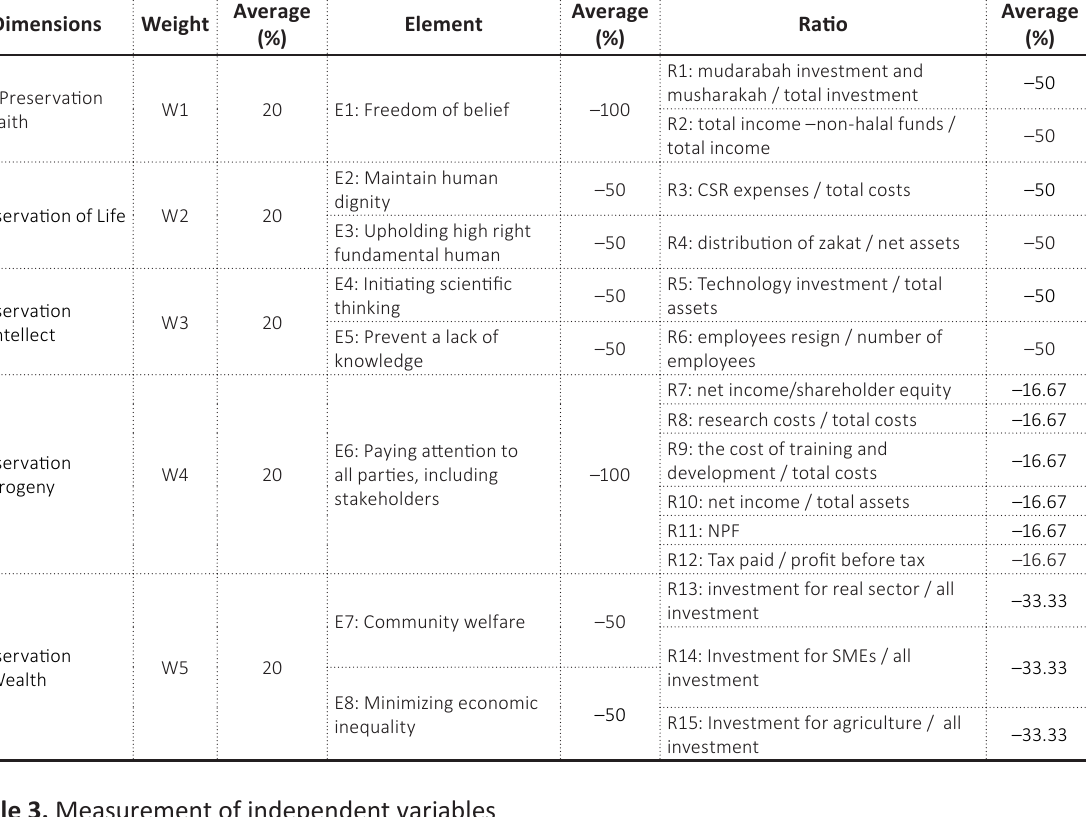
Table 2. Maqasid shariah index calculation Dimensions